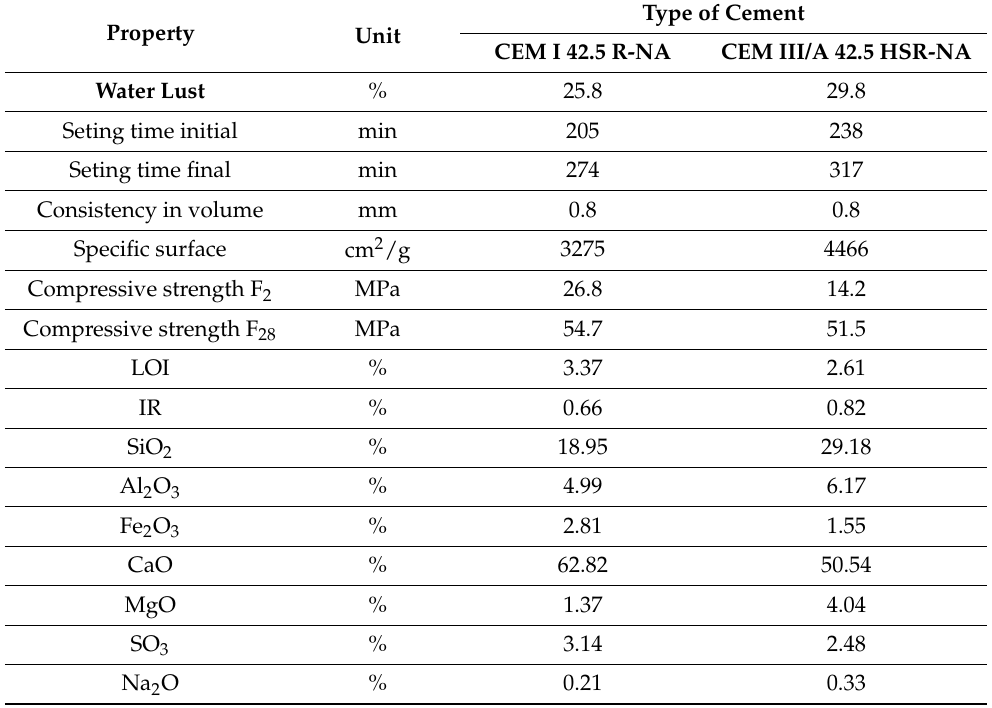
Table 1. Properties of cements provided by the